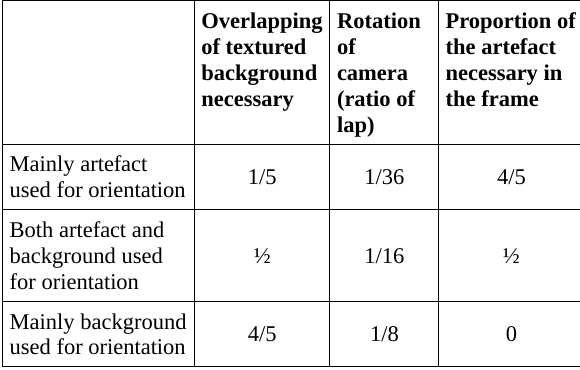
Table 2. recommended parameters for automatic orientation